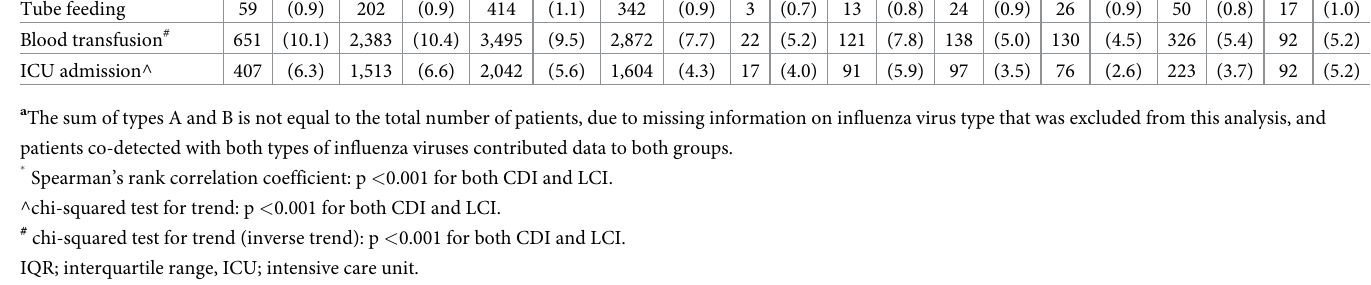
a The sum of types A and B is not equal to the total number of patients, due to missing information on influenza virus type that was excluded from this analysis, and patients co-detected with both types of influenza viruses contributed data to both groups. � Spearman’s rank correlation coefficient: p < 0.001 for both CDI and LCI. ^chi-squared test for trend: p < 0.001 for both CDI and LCI. # chi-squared test for trend (inverse trend): p < 0.001 for both CDI and LCI. IQR; interquartile range, ICU; intensive care